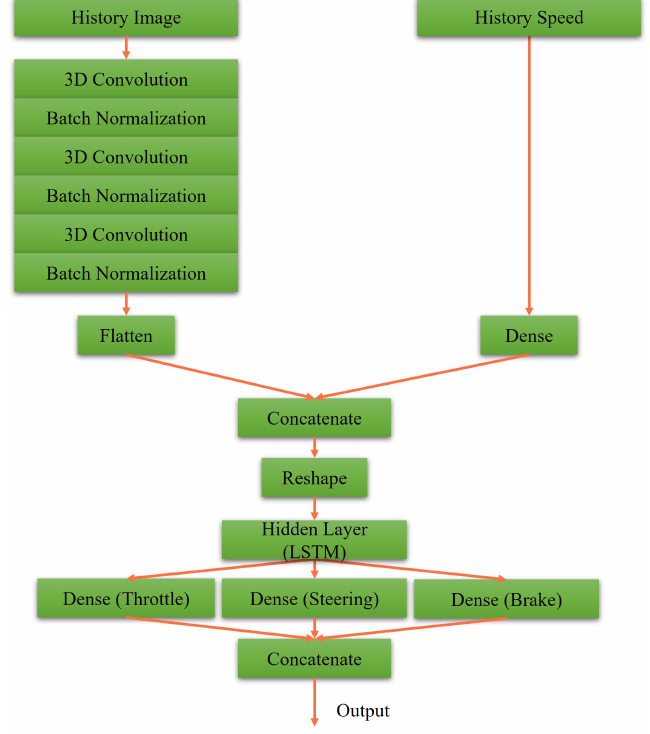
Figure 9. Our actor network for RDPG.